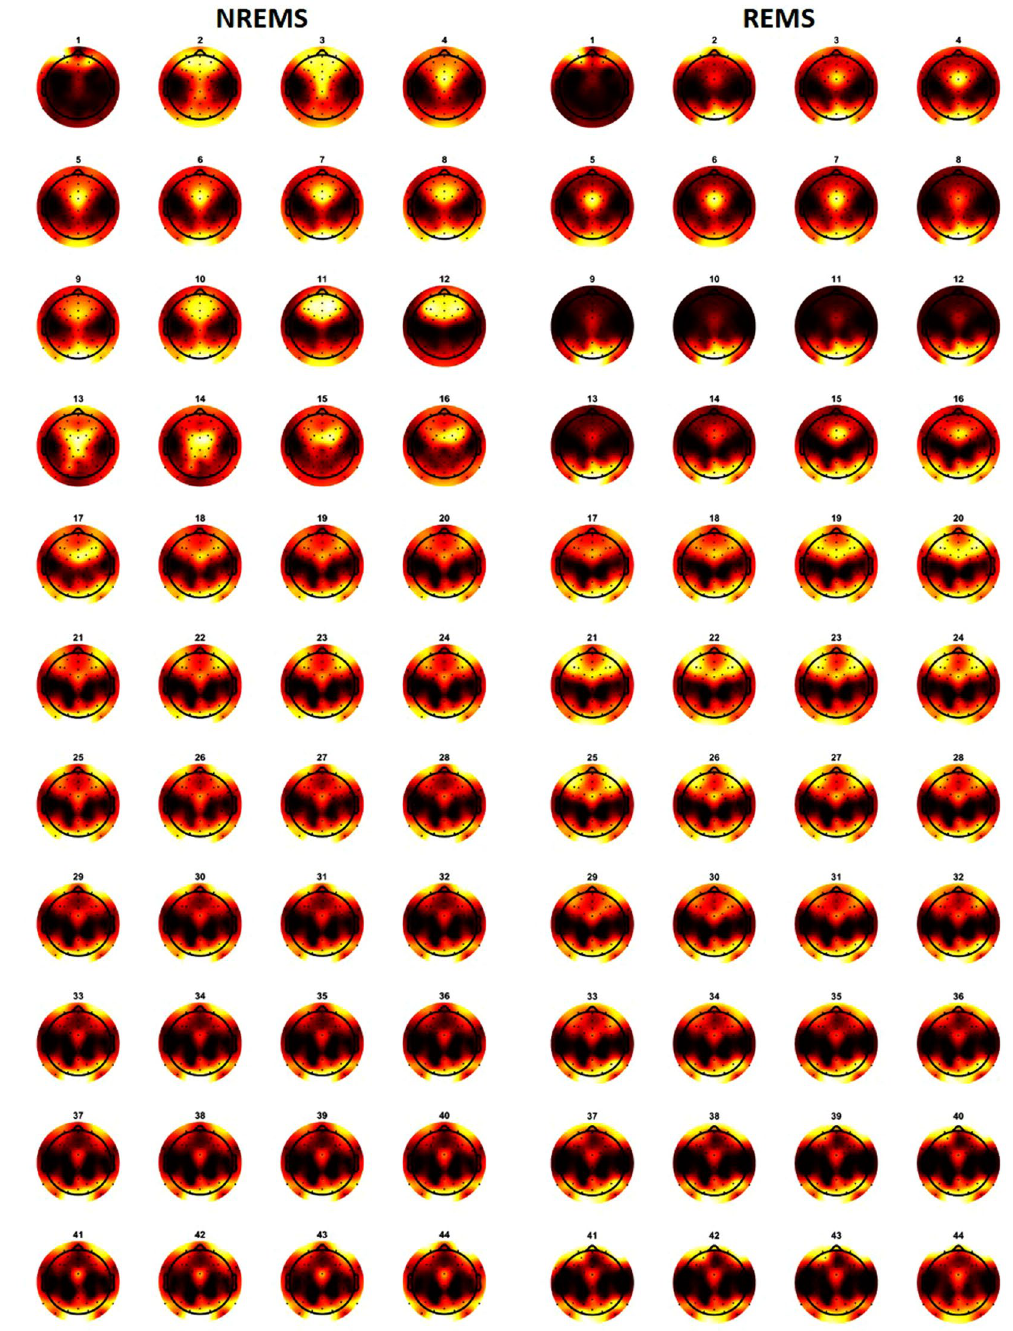
Figure 6. Average (n = 50) topographic distribution of EEG power normalized to the total power during NREMS and REMS for 1 Hz bins up to 44 Hz. The numbers indicate the upper limit of the frequency bin (e.g., 1 corresponds to the five 0.2-Hz bins centered at 0.2, 0.4, 0.6, 0.8 and 1 Hz). Each map was scaled separately between its minimal and its maximal